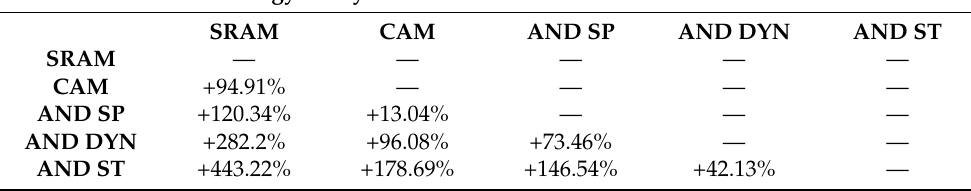
Table 4. Percentage differences in the read energy-delay product among the arrays. Each value corresponds to the increase, expressed in percentage, in the energy-delay product of the memory on the corresponding row with respect to the one of the memory on the corresponding column. Some values are omitted for the avoid ambiguities in the table interpretation (i.e., each percentage value is calculated using as reference the memory on the column and each comparison is made only one time per memory). The data are extracted from Table 3.